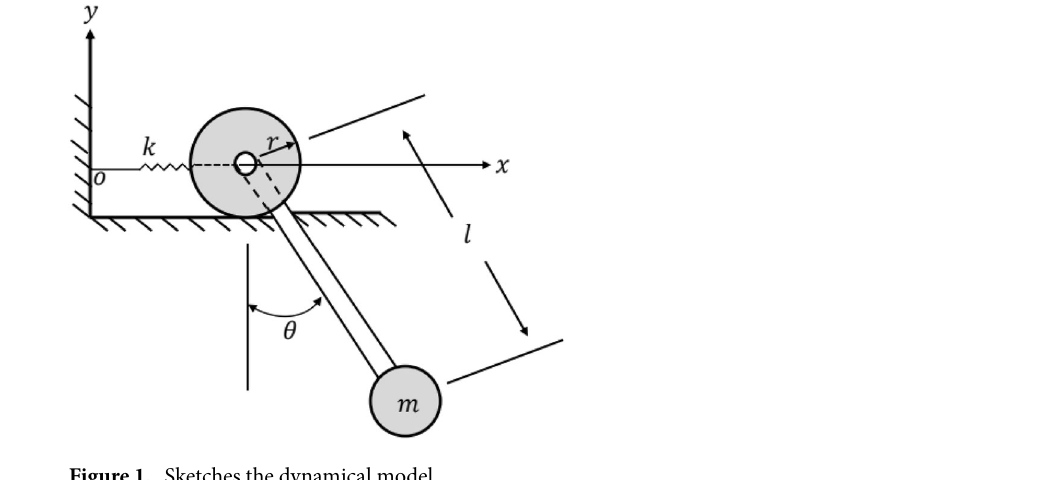
Figure 1. Sketches the dynamical